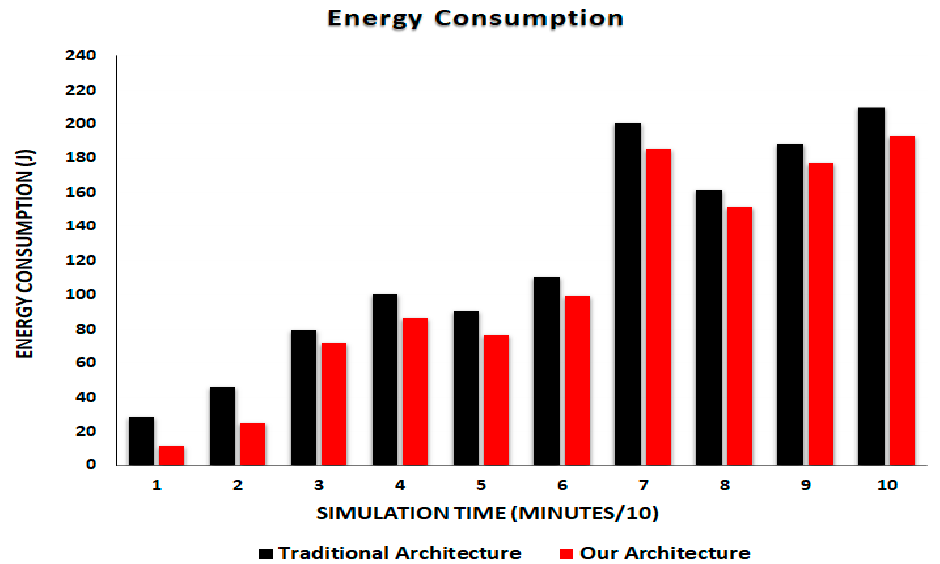
Figure 9. Energy consumption average.